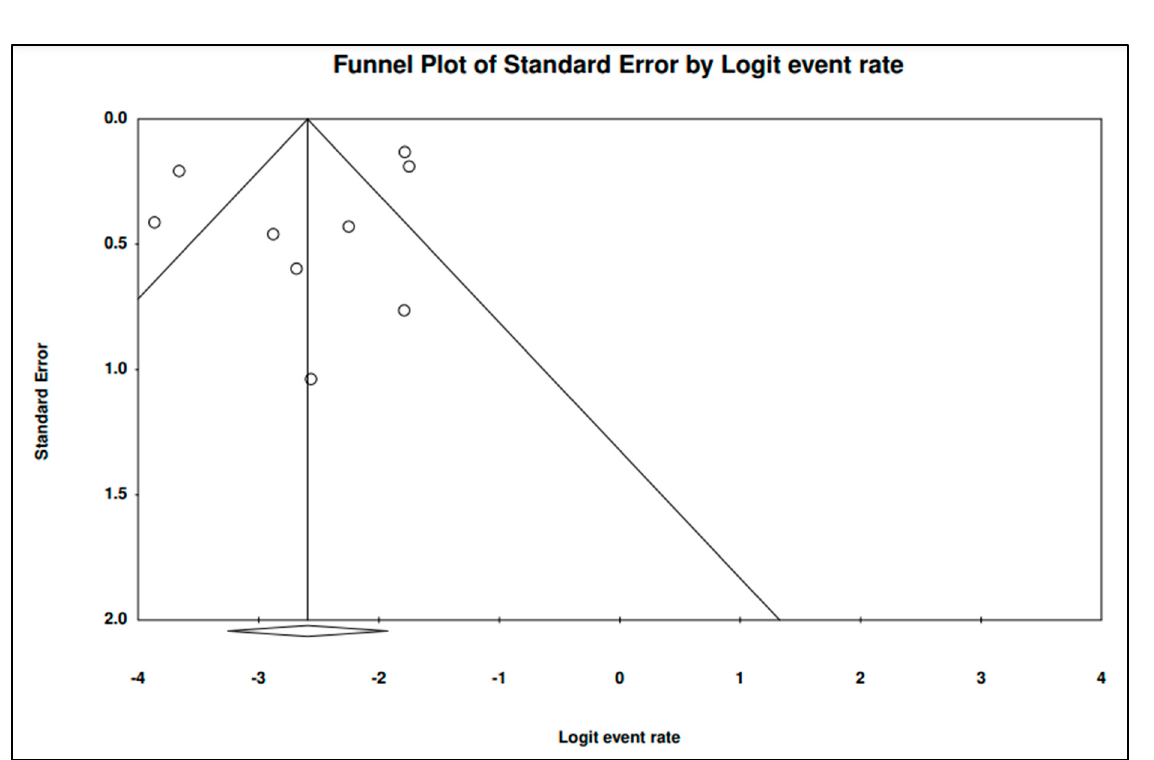
Figure 12. Funnel plot showing publication bias in studies reporting the prevalence of parE gene in antimicrobial resistance S. Typhi.